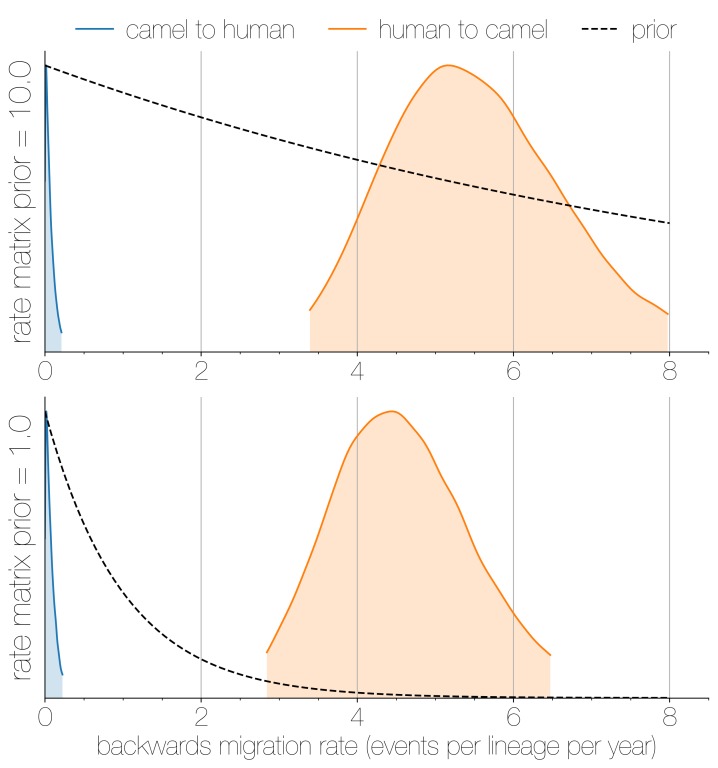
Posterior backwards migration rate estimates for two choices of prior.Negligible flow of MERS-CoV lineages from humans into camels is recovered regardless of prior choice (note that rates are backwards in time). Plots show the 95% highest posterior density for the estimated migration rate from the human deme into the camel deme looking backwards in time (orange) and vice versa (blue). Dotted lines indicate exponential priors specified for migration rates, with mean 1.0 (bottom) or 10.0 (top).